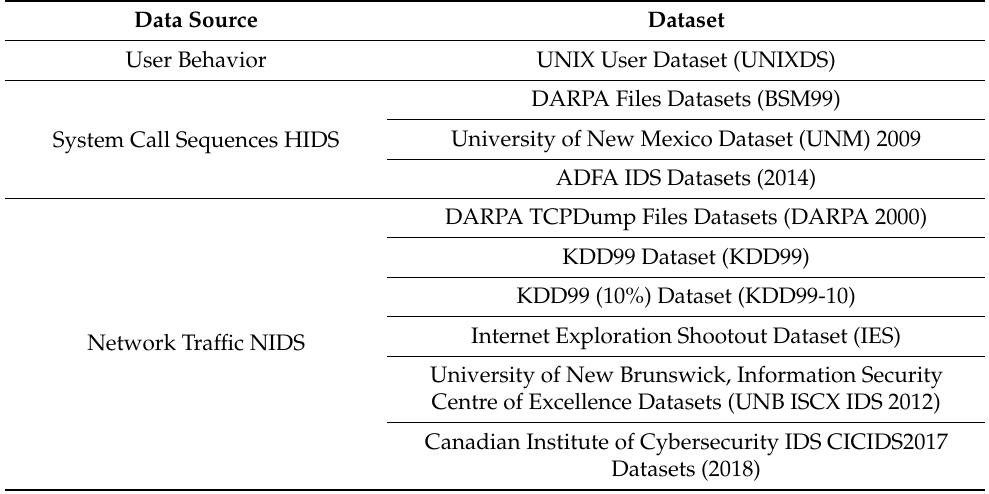
Table 3. Frequently used datasets in IDSs